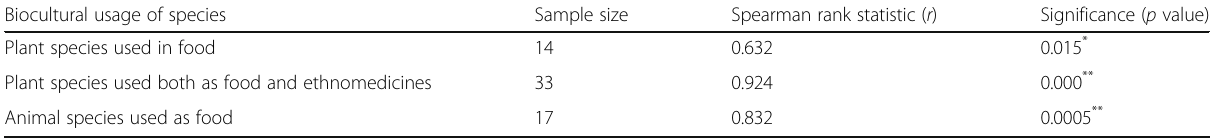
Table 6 Association between usage and conservation of species Biocultural usage of